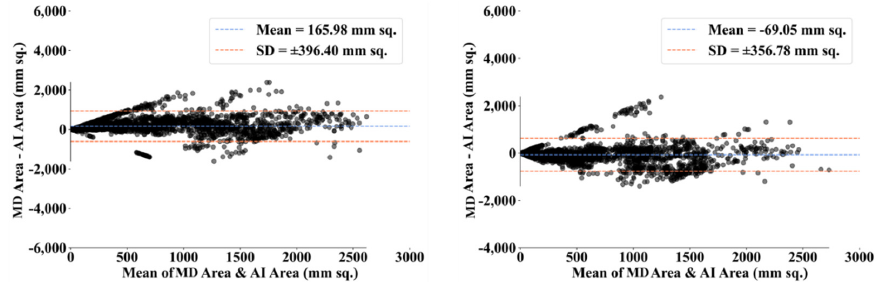
Figure 30. BA plot for ResNet ‐ UNet using MD 1 (left) vs. MD 2 (right).